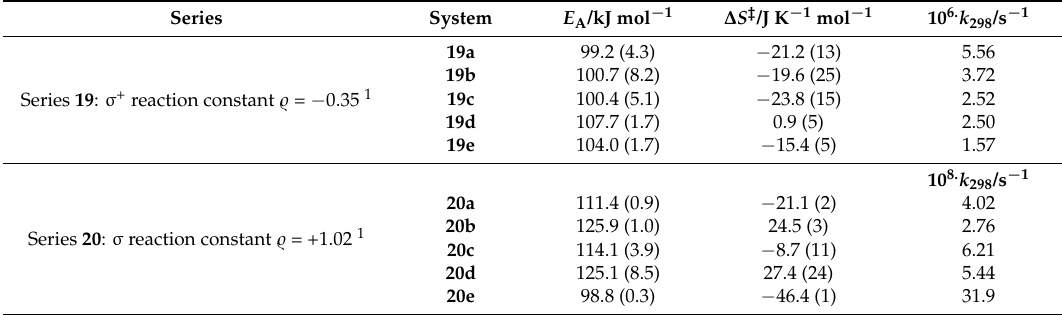
Table 6. Hammett reaction constants, Arrhenius activation energies, entropies of activation, and rate constants for HERON decomposition of 19a – e and 20a – e